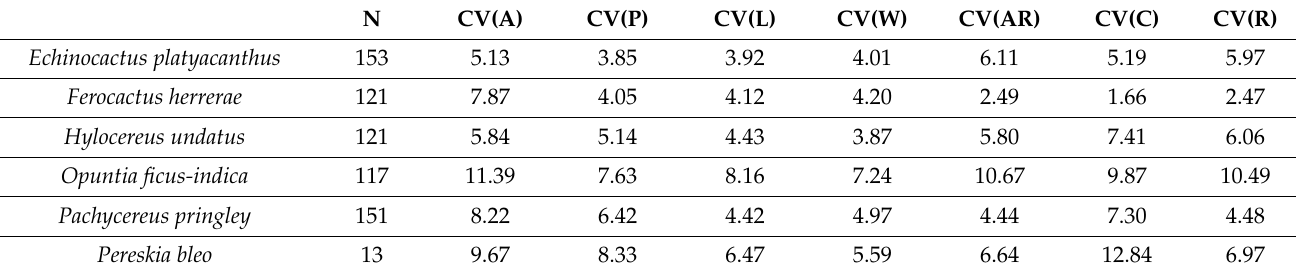
Table 2. Values of the coefficient of variation for area (CV(A)), perimeter (CV(P)), length (CV(L)), width (CV(W)), aspect ratio (CV(AR)), circularity (CV(C)), and roundness (CV(R)) in seed samples of six species belonging to different subfamilies of the Cactaceae. N indicates the number of seeds